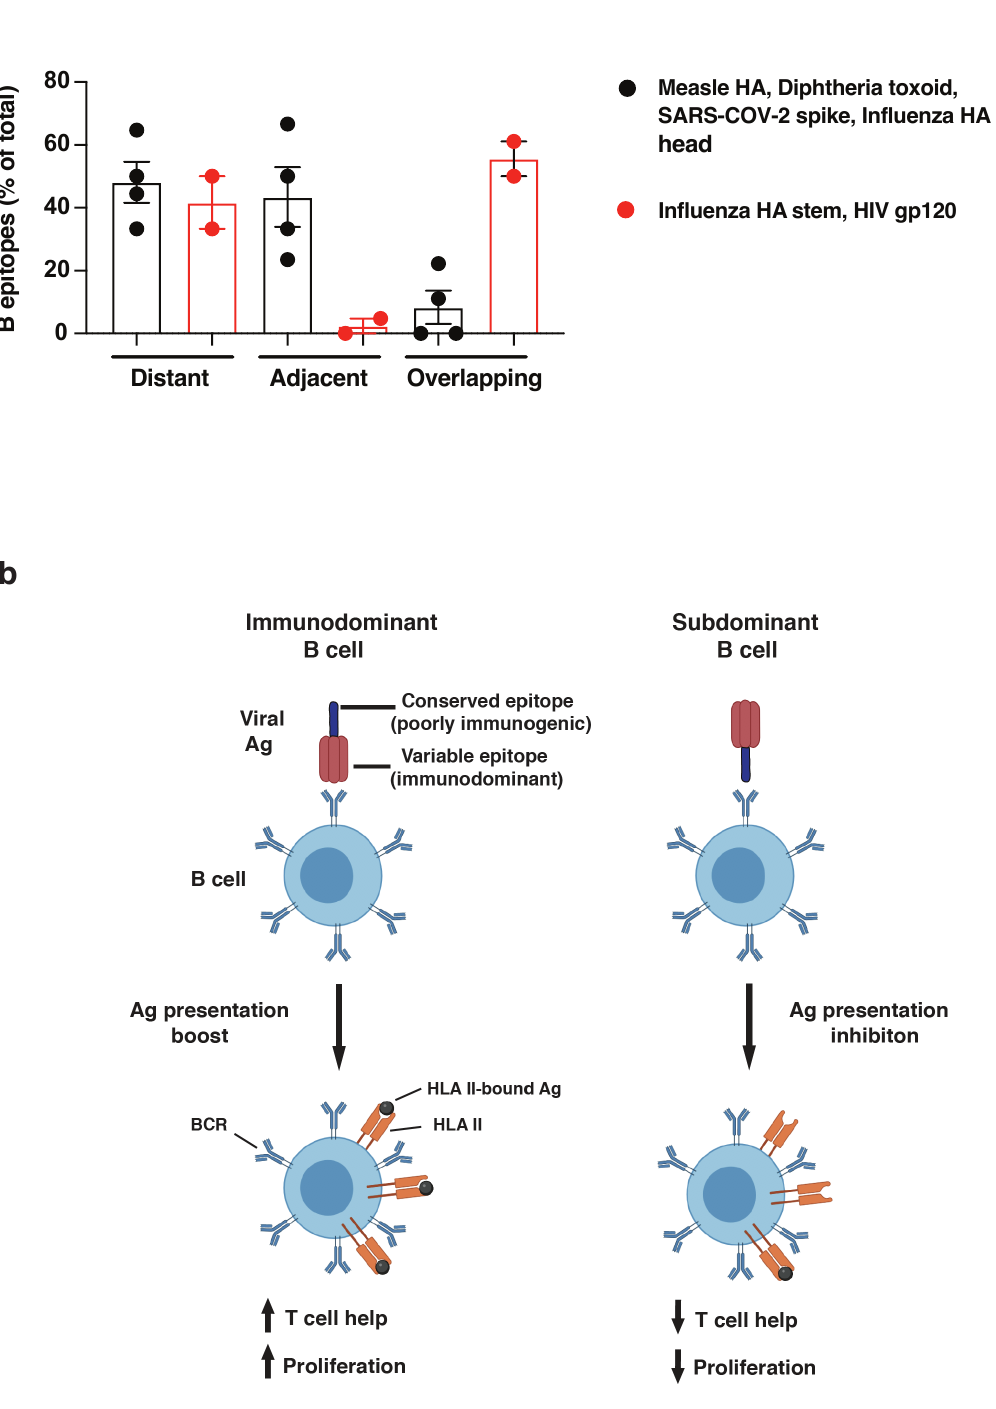
Figure 5. ( a ) Quantification of dominant B cell epitopes classified as distant from (>15aa), adjacent to (<15aa), or overlapping with (<0aa) immunodominant CD4 determinants within the same antigen. Good nAb inducers (measles HA, diphtheria toxoid, SARS-CoV-2 spike, and influenza HA head: black dots) and poor nAb inducers (influenza HA stem and HIV gp120: red dots) are compared. Chi-squared analysis was applied (see Table S7). ( b ) Model figure showing immunodominant B cell (left) recognizing immunogenic viral regions and boosting antigen presentation upon BCR binding; right, subdominant B-cell clone binding conserved/poorly immunogenic viral regions and inhibiting presentation of overlapping CD4